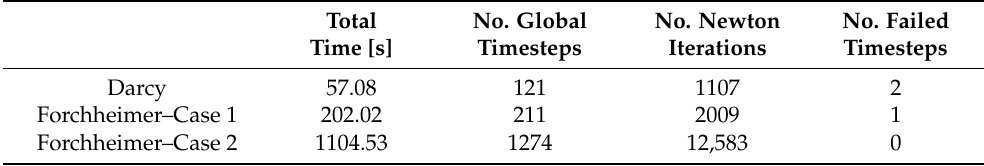
Table 4. Computational effort and numerical behavior for Scenario